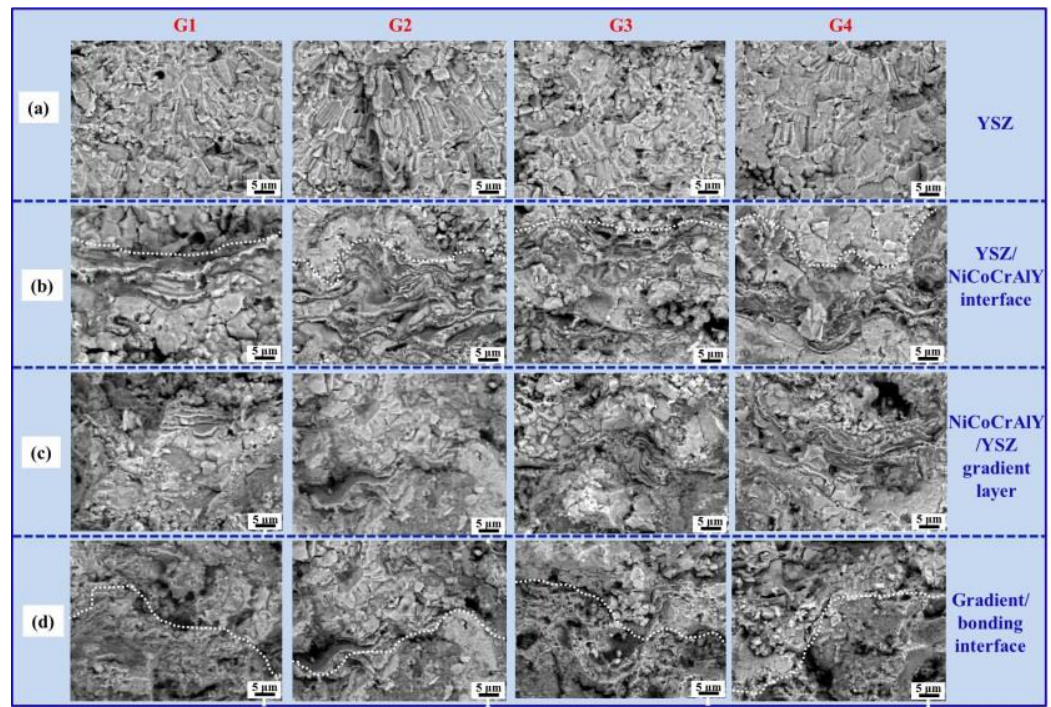
Figure 9. Fractured morphology of failure coating for different layers after thermal cycles test: ( a ) YSZ layer; ( b ) YSZ/NiCoCrAlY interface; ( c ) NiCoCrAlY/YSZ gradient layer; ( d ) NiCoCrAlY/YSZ gradient layer and NiCoCrAlY bonding interface.